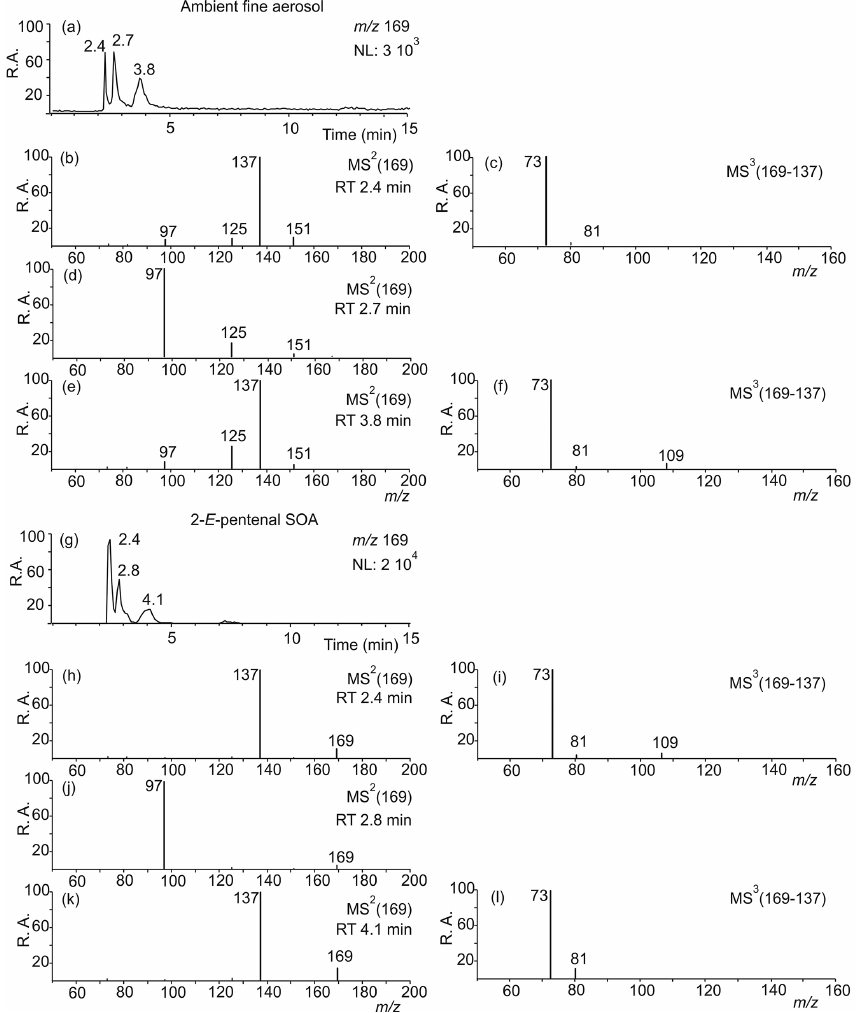
Figure 5. Selected LC–MS chromatographic data ( m/z 169 EICs) and selected MS data (MS 2 or MS 3 product ion spectra) for ambient fine aerosol (a – f) and 2- E -pentenal SOA (g – l) . Abbreviation: NL, normalization